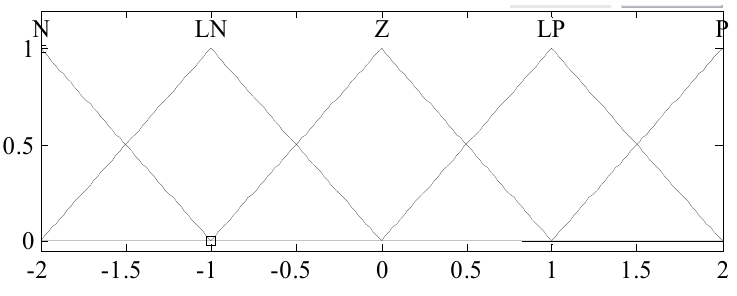
Figure 5. Output variable “actuatinsig” of FLC.